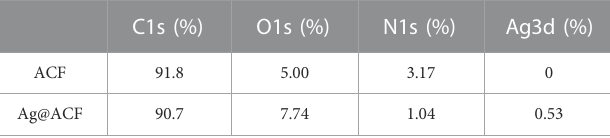
TABLE1Quanti fi cationoftheatomicpercentageofspeciesfoundontheACFand Ag@ACF